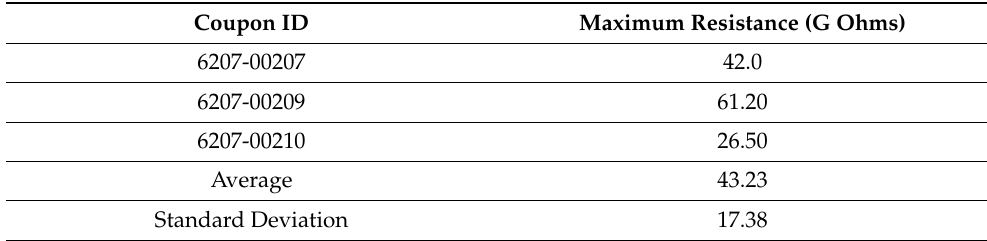
Table 2. Summary of electrical properties of multifunctional carbon fiber